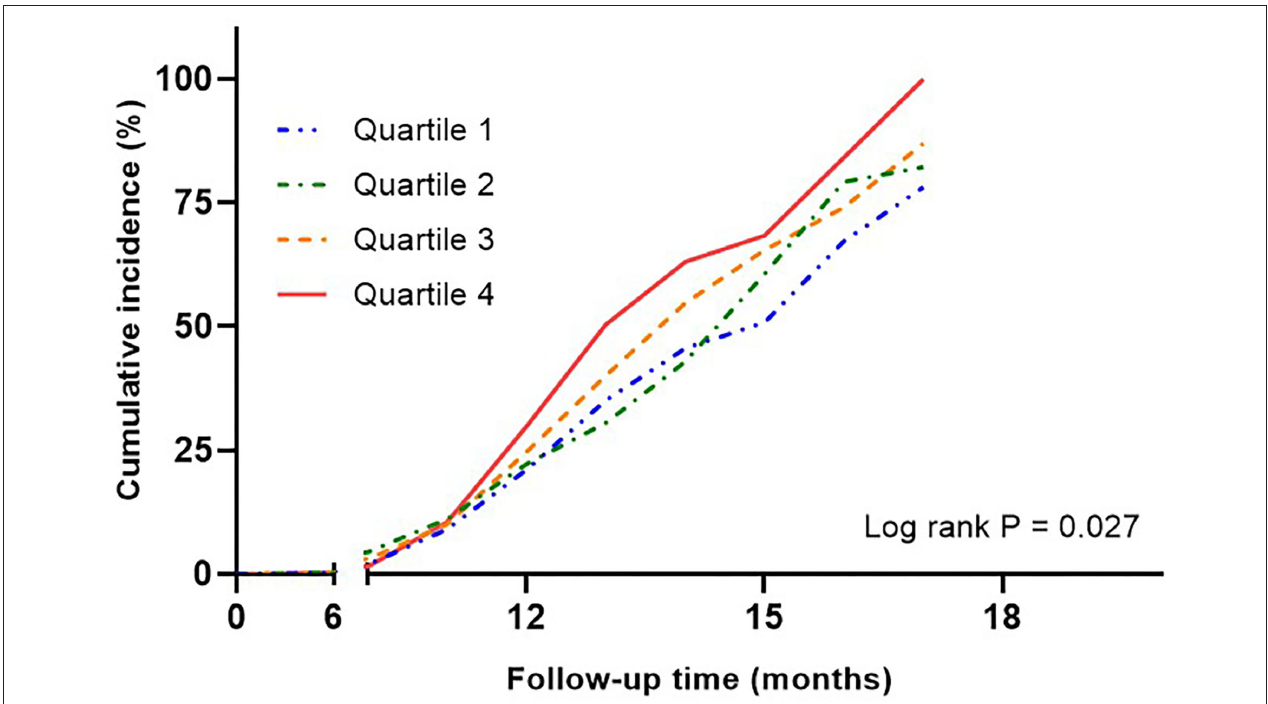
FIGURE 3 | Kaplan-Meier curves assessing cumulative incidence by quartiles of uric acid variability in risk of cardiovascular disease. Adjusted for age, sex, baseline uric acid, hypertension, statin use, eGFR, HbA1c, and duration of diabetes. eGFR, estimated glomerular filtration